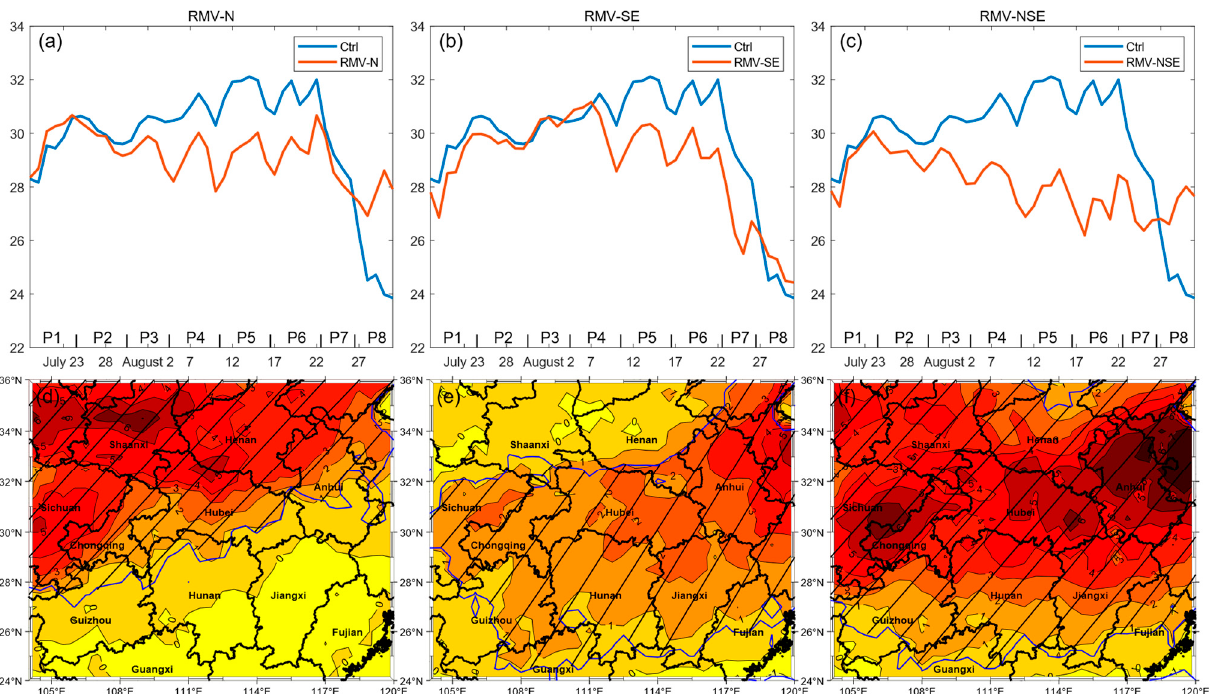
Figure 11. ( a – c ) Area average T max comparison between the control run (blue line; ◦ C) and the sensitivity runs (red lines; ◦ C). ( d – f ) The difference in average T max (shading; ◦ C) in sensitivity runs compared with the control run. Slash hatches show that the area passed the 95% significance test.